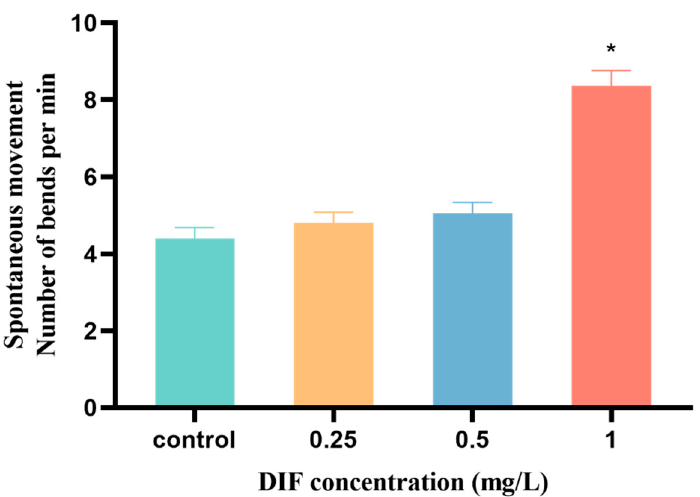
Figure 2. Spontaneous movement of zebrafish embryos exposed to difenoconazole (0, 0.25, 0.5, and 1 mg/L) at 24 hpf. Values are presented as the mean ± SEM with 3 replicates (10 larvae/replicate). * p < 0.05 indicates significant differences between exposure groups and the control group.